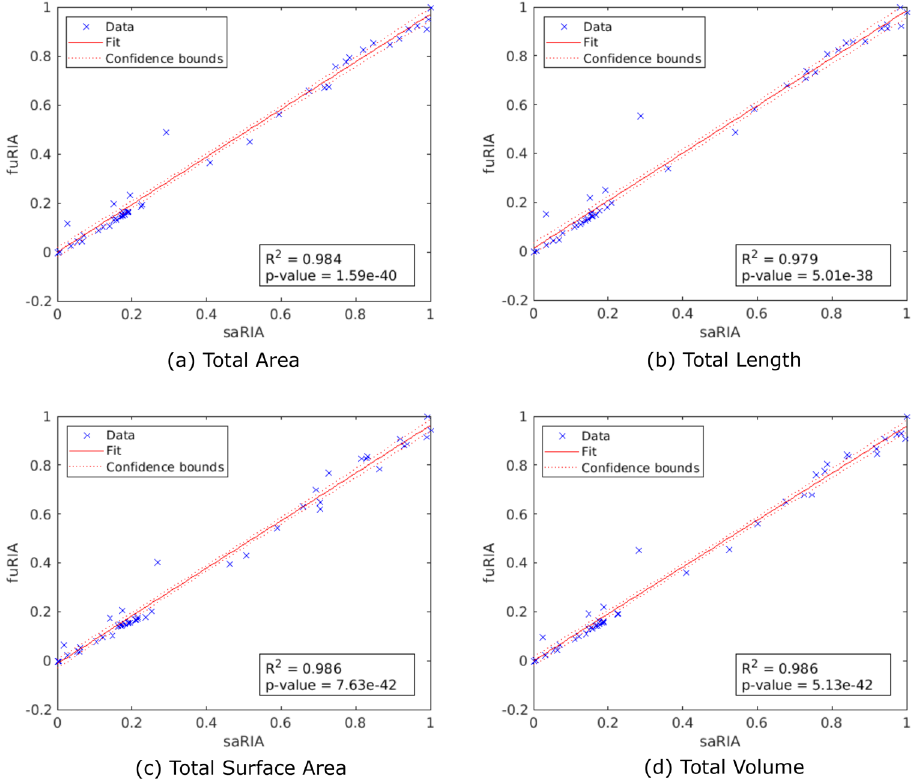
Figure 11. Correlation between root traits calculated using semi-automated saRIA (x-axis) and fully-automated faRIA (y-axis) image segmentation. Each point represents a trait value estimated from one of 40 soil-root images from rhizotron imaging system. The red colour solid line and dotted lines represent a fitted curve and 95% 2 confidence bounds, respectively. The R value indicates good conformity between saRIA and faRIA results of image segmentation and trait calculation.